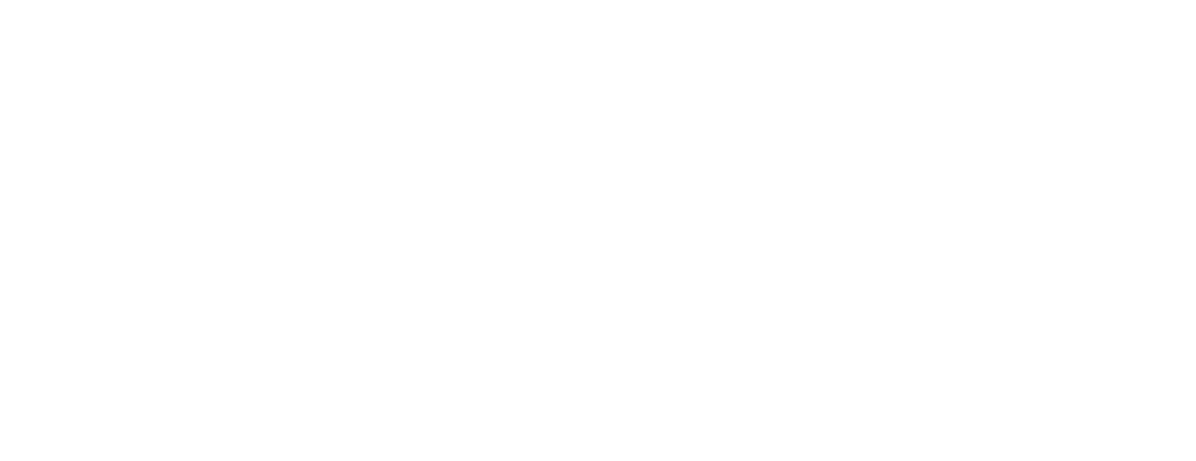
FIGUREA6 | Comparison of the putative amino acid sequences of MeYSL and other plantYSL proteins. Identical and conservative amino acids are shaded in black and gray, respectively. Dashes indicate gaps. Fourteen transmembrane domains (TM) were identified usingTMHMM and are shown